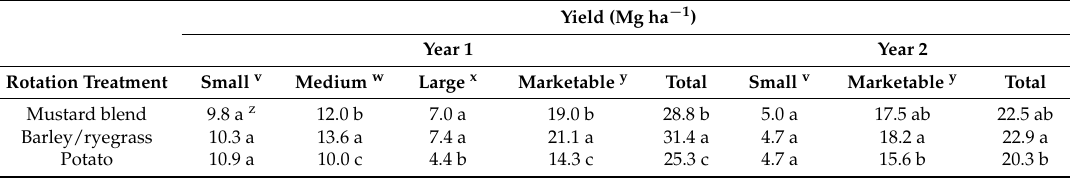
Table 7. Average potato tuber yield in various size classes, marketable and total yield as affected by previous rotation crop treatments at the Newport site in potato Years 1 and